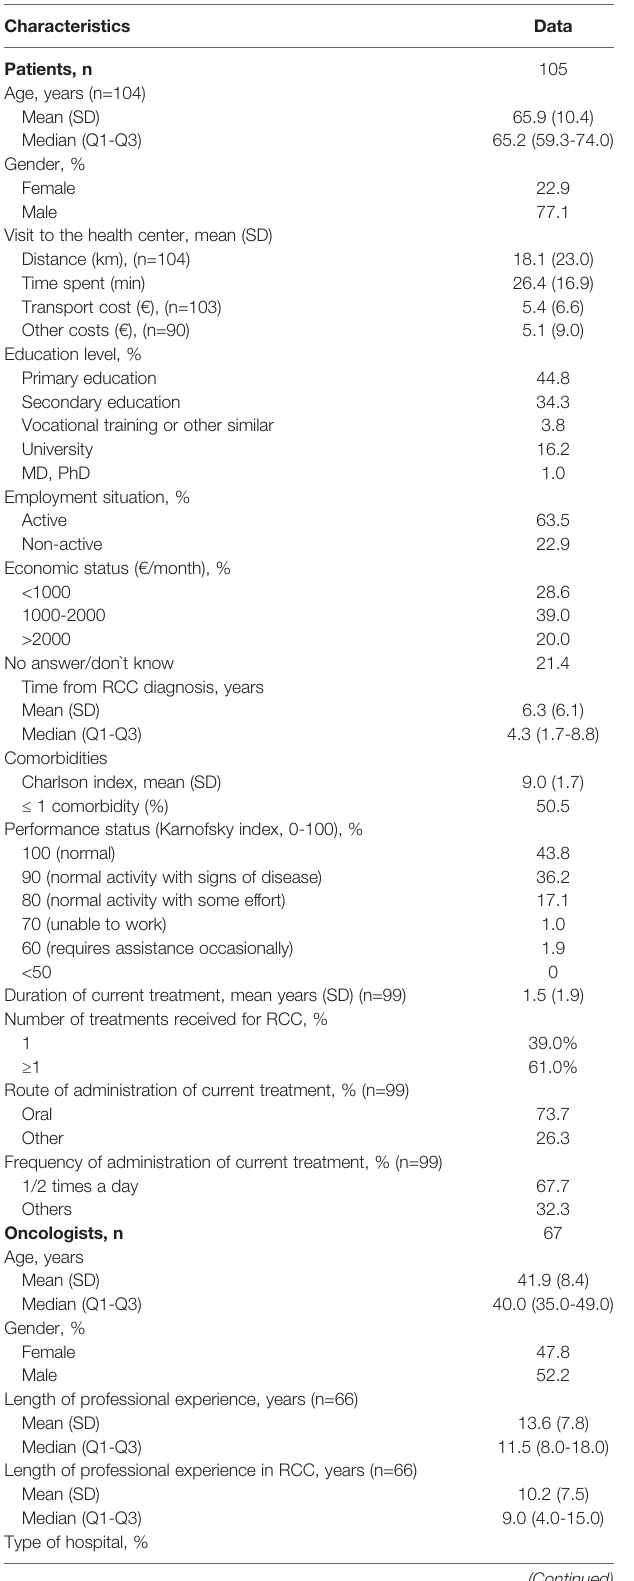
TABLE 3 | Sociodemographic characteristics of patients and